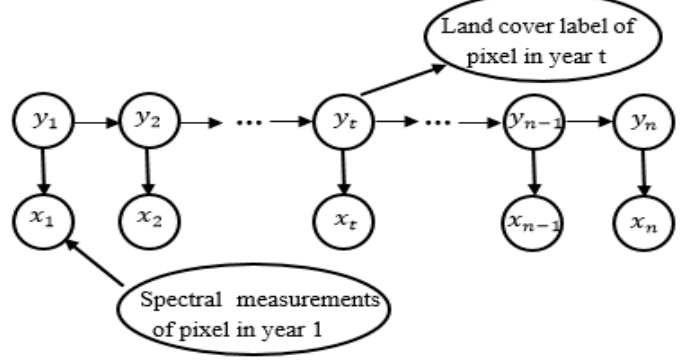
Figure 1. Schematic of a hidden Markov model (HMM).